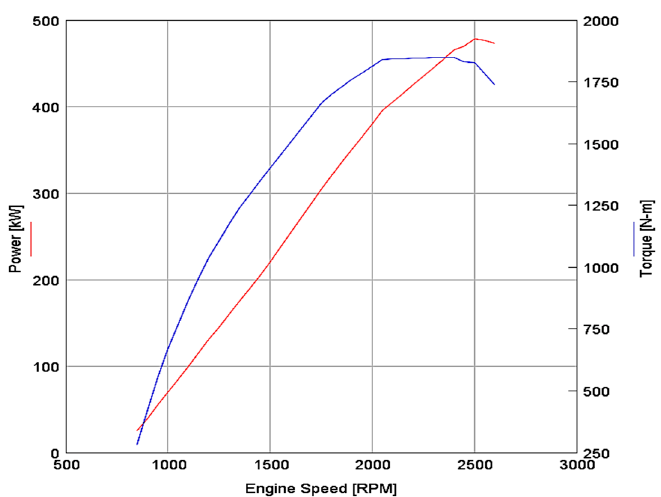
Figure 6. Baseline Power vs. Torque.